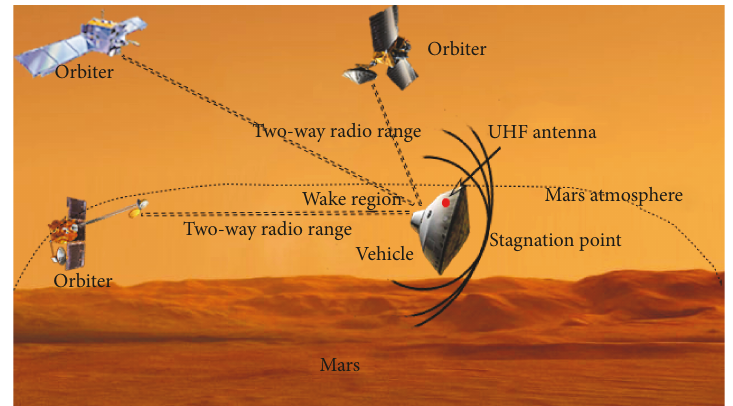
Figure 1: Diagram of three orbiter navigation scenarios, stagnation point, and wake